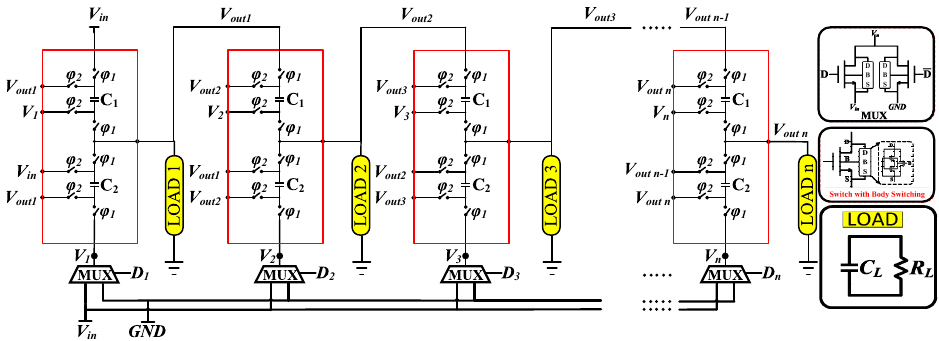
Figure 2. Block diagram of the proposed n -bit SSC-DVS (Dynamic Voltage Scaler) architecture.